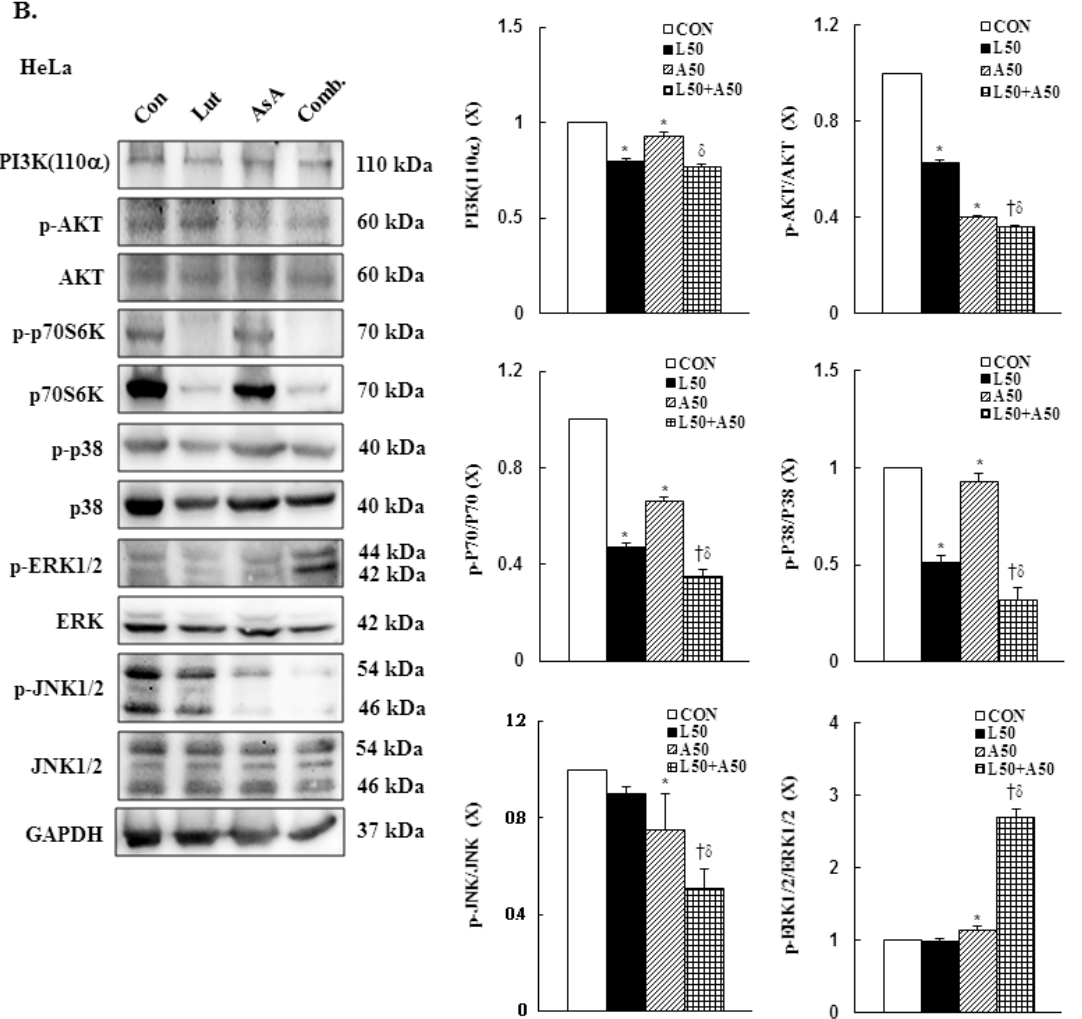
Figure 7. Luteolin combined with asiatic acid induced apoptosis through inhibition of PI3K/AKT and regulation of MAPKs pathways in cervical cancer cells. Western blotting was used to detect PIK3CA, p-AKT, AKT, p-70S6K, 70S6K, p-p38, p38, p-ERK1/2, ERK1/2, p-JNK1/2 and JNK1/2 levels in CaSki ( A ) and HeLa ( B ) cells treated with Lut (50 µ M) or AsA (50 µ M) alone or in combination for 24 h. GAPDH served as the loading control. Quantitative results are shown in the lower plot. Values represent mean ± SD from three replicates. *, † and δ p < 0.05 compared with CON, L50- or A50-treated group. CON, 0.1% DMSO; L50, 50 µ M luteolin; A50, 50 µ M asiatic acid; Comb., 50 µ M luteolin + 50 µ M asiatic acid.